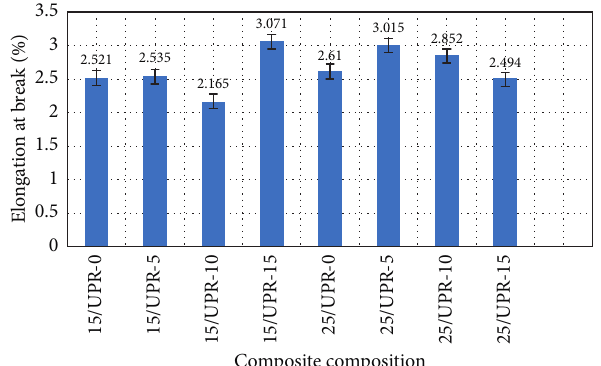
2 O 3 filler and chopped flax